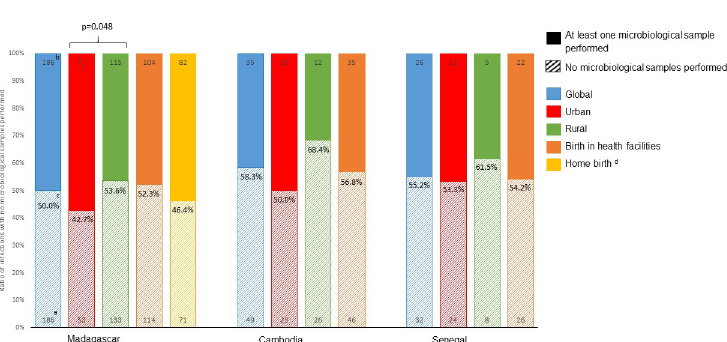
Fig 2. Ratio of SBIs without microbiological samples performed. Total SBIs include both culture-confirmed SBI and pSBI. (a) Numbers at the bottom of each bar represent the number of neonatal SBI with no microbiological samples performed. (b) Numbers at the top of each bar represent the number of neonatal SBI with at least 1 microbiological sample performed among blood culture, urine test, and lumbar puncture. (c) Percentages in the middle of each bar represent the ratio of neonatal SBI with no microbiological samples performed (number of neonatal SBI without microbiological samples performed/ overall number of neonatal SBI). (d) Only in Madagascar ( > 98% of the pregnant women delivered in healthcare facilities in Cambodia and Senegal). p AU : AbbreviationlistshavebeencompiledforthoseusedthroughoutFigs 2 and 4 : Pleaseverifythatallentriesarecorrect : SBI, possible severe bacterial infection; SBI, severe bacterial infection.